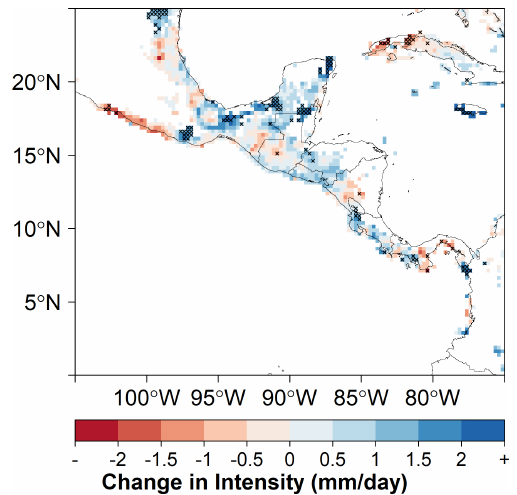
Figure A2. The change in MSD intensity between the early (1981– 2000) and late (2001–2020) periods. Grid cells marked with an “X” show statistically significant